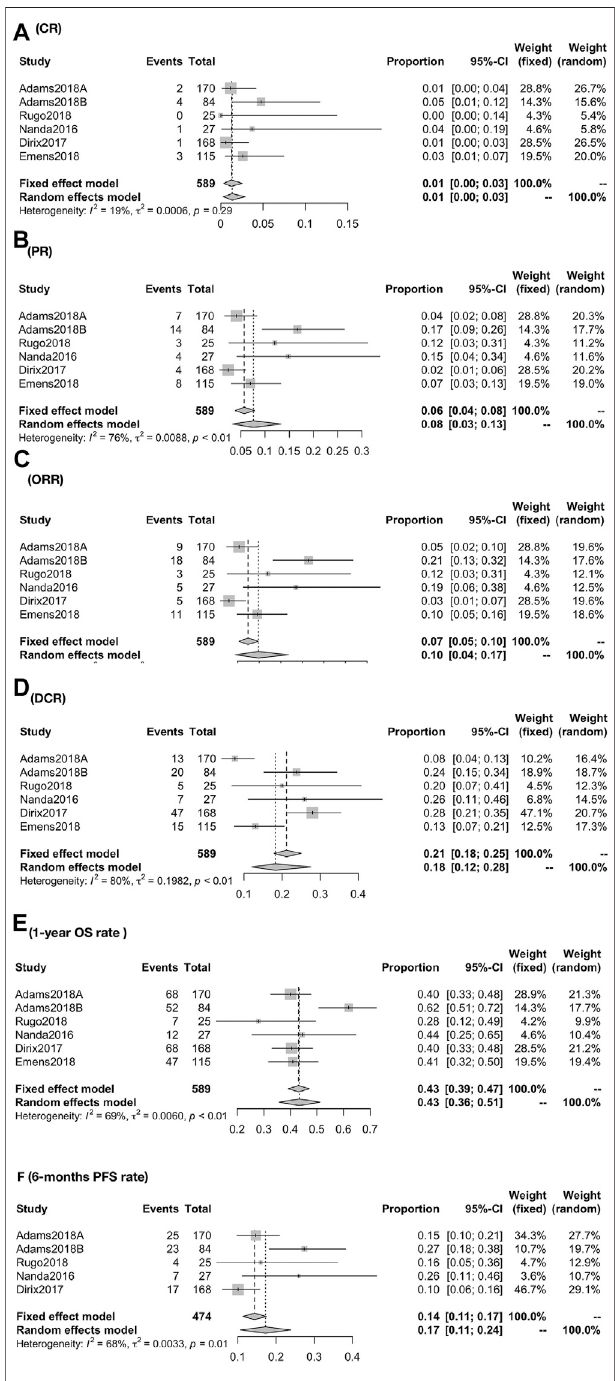
FIGURE2| GlobalresponserateforpatientsofCR (A) ,PR (B) ,ORR (C) , DCR (D) , 1-year OS rate (E), and 6-months PFS rate (F) . The global response rate consists of CR, PR, ORR, and DCR. The global CR was 1.26% (95% CI, 0.35 – 2.54; I 2 , 19.10), PR was 7.65% (95% CI, 3.32 – 13.37; I 2 ,